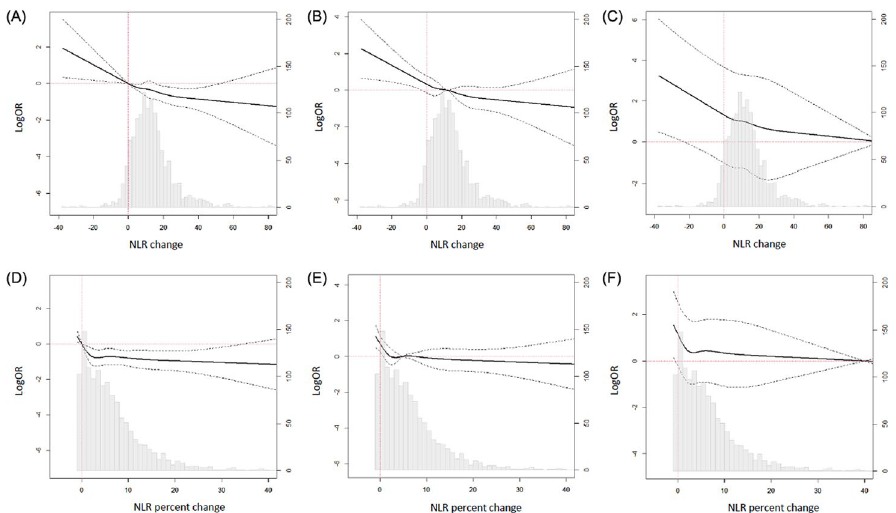
Figure 1. Smooth plots of the change of odds ratio for 1-year graft failure when the reference value was ( A ) absolute NLR change of 0, ( B ) median value of absolute NLR change, ( C ) 80% of absolute NLR change, ( D ) NLR percentage change of 0, ( E ) median value of NLR percentage change, and ( F ) 40% of NLR percentage change. (NLR percent change defined as [postoperative NLR − preoperative NLR]/preoperative